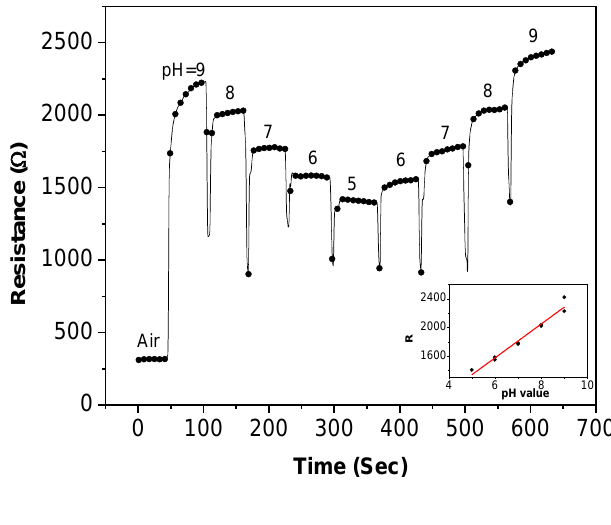
Figure 6. The recorded resistance history of a SWNT-based sensor when exposed to pH buffers from pH-9 to pH-5 and then to pH buffers from pH-5 to